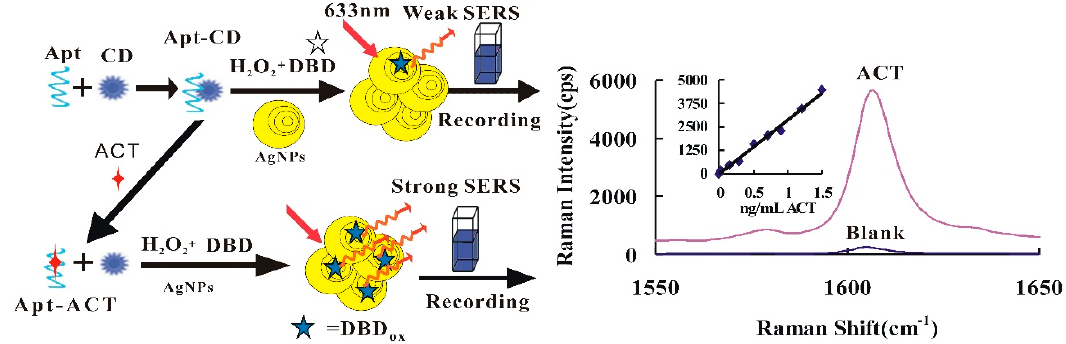
Figure 1. Carbon dot (CD) catalytic amplification surface-enhanced Raman scattering (SERS) analytical platform based on aptamer with 3,3’-dimethylbiphenyl-4,4’-diamine (DBD) oxidizing reaction.